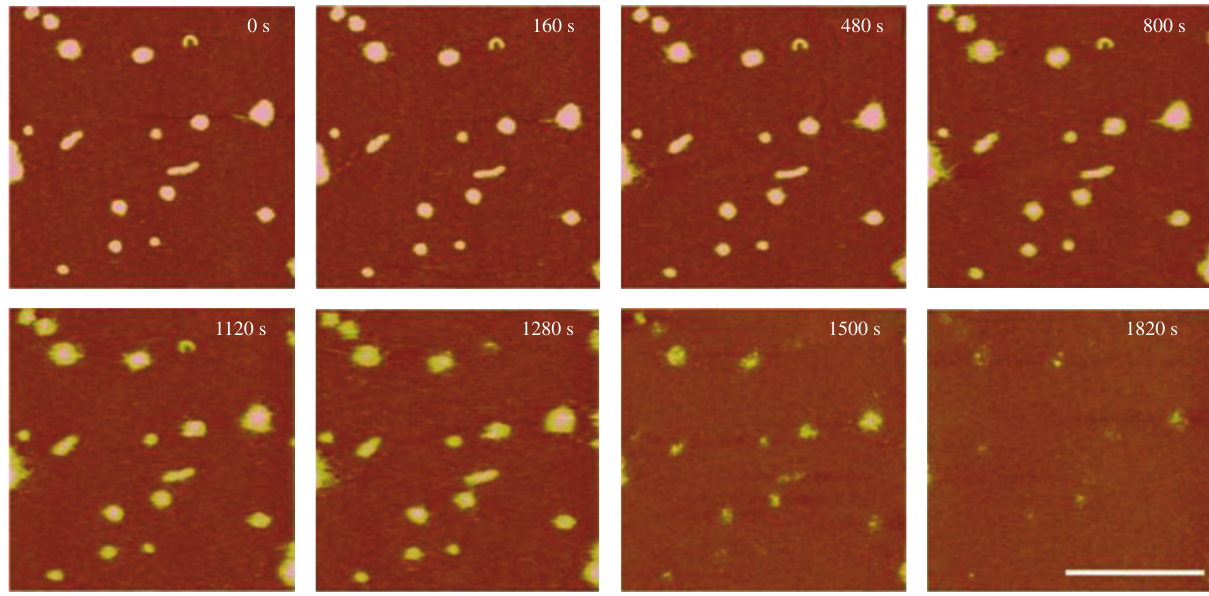
Figure 10: In situ AFM sequence of DNA release from nuclear localization signal peptide (NLS 6 + )/DNA polyplexes (N/P = 4) in 20 mM dithi- othreitol (DTT) and 0.4 M NaCl solution (no Mg2 + was added). Time zero corresponds to the addition of DTT. The z range is 10 nm. Scan size is 2.6 × 2.6 μ m 2 . Reprinted from Allen et al.